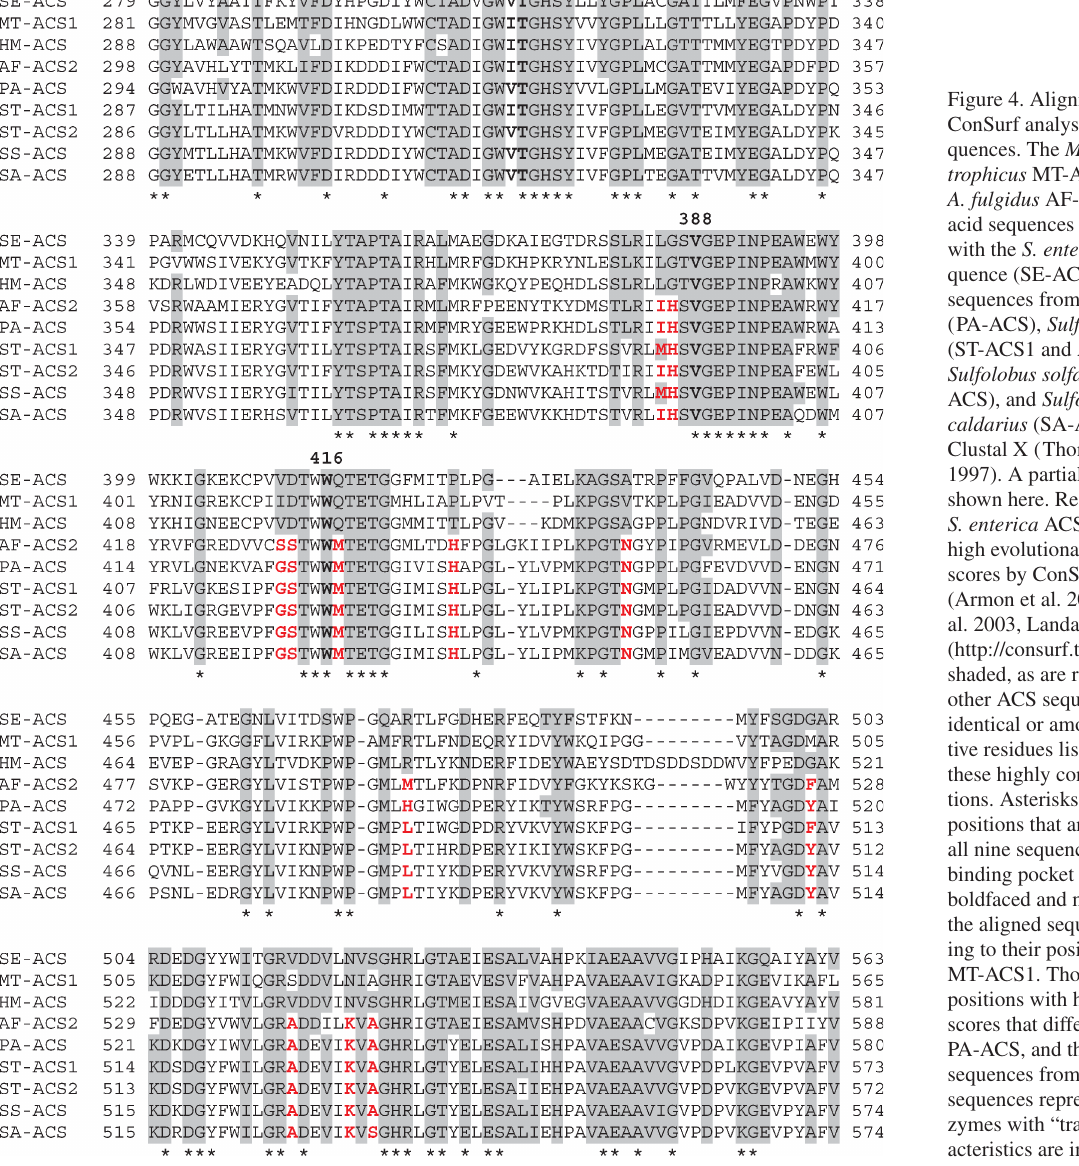
the equivalent residue Leu 441 of AF-ACS2. The overall in- creased hydrophobicity of the acyl substrate binding pocket of AF-ACS2 may positively influence substrate affinity, but it is likely that the combined effects of multiple residues are re- quired to determine whether the enzyme has a narrow or broad substrate range.